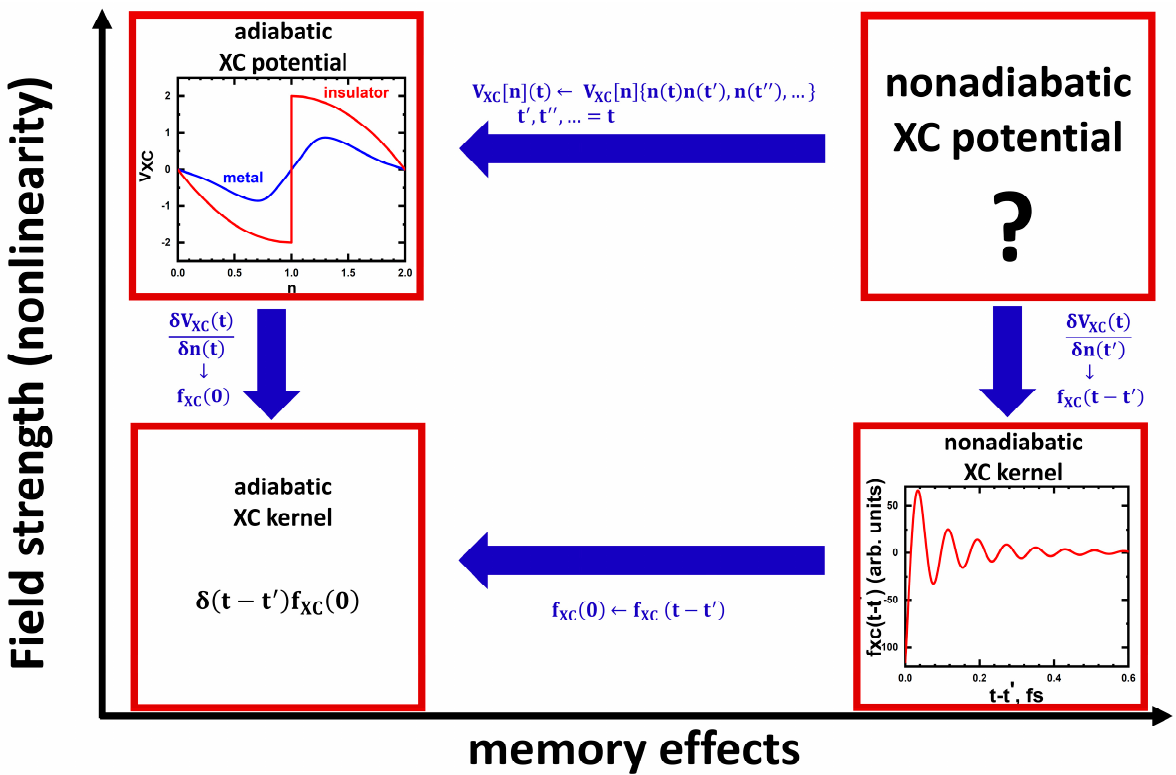
Figure 1. Schematic representation of approximations for the nonadiabatic XC potential for strongly correlated materials in the cases of different strengths of the external perturbation (nonlinearity) and different levels of importance of the memory effects. The approximated potentials (the two left and the right-bottom boxes) are obtained with DMFT. The general structure of the exact nonadiabatic XC potential (top right box) is not known.